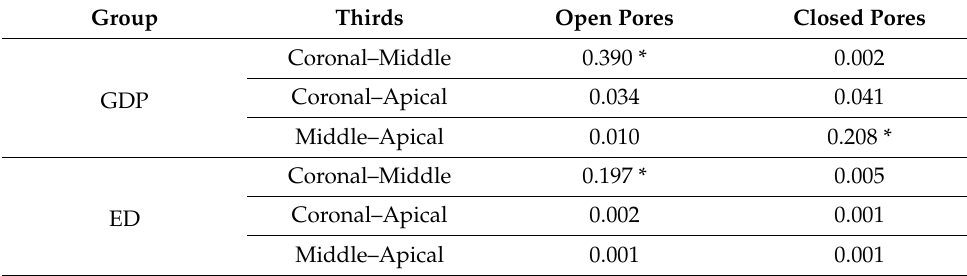
Table 2. p -values from pairwise comparison of thirds in the same group.